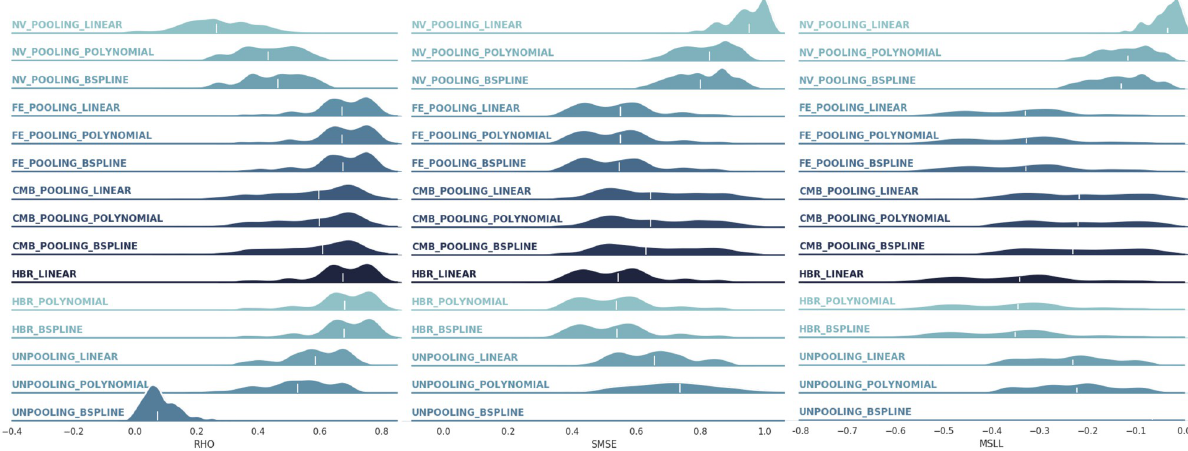
Fig 7. The distributions of correlation, SMSE, and MSLL across 148 cortical areas in the multi-site data regression. The white lines highlight the medians of distributions. Abbreviations: NV = naive, FE = fixed effects, CMB = ComBat, HBR = hierarchical Bayesian regression. The HBR and fixed- effect modeling show equivalently better regression performance compared to other